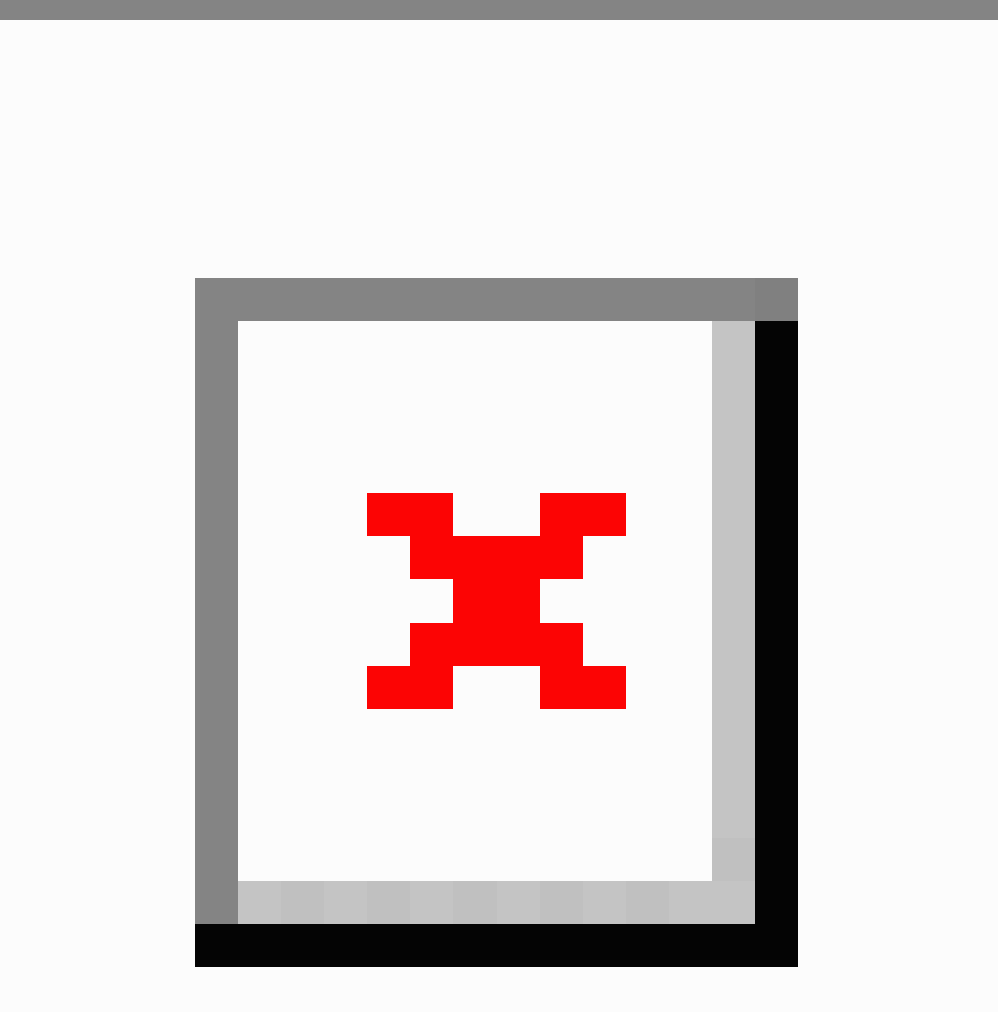
Figure 5. Screen appearance of the patient training area and principal features of the game arena.